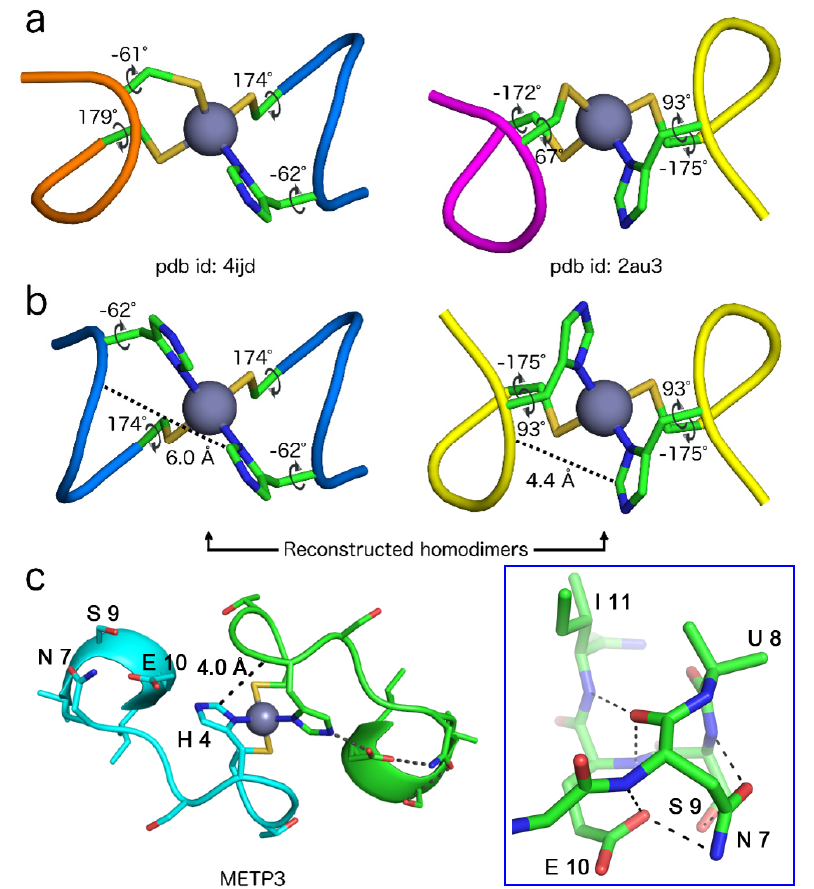
Figure 9. ( a ) Almost symmetrical Cys 3 His dimers, from 4ijd (left) and 2au3 (right), in which sym- metry-related coordinating residues adopt the same χ 1 torsion angles. ( b ) Possible homodimeric models, reconstructed from the C-X 1 -X 2 -H-X 3 motifs, extracted from 4ijd (left) and 2au3 (right). ( c ) Final molecular model of Zn(II)-METP3 complex, with the observed hydrogen bond network, comprising Asn7-Aib8-Ser9-Glu10-Ile11, highlighted in the blue box. In all panels, the metal ions are reported as spheres and side chains as sticks.